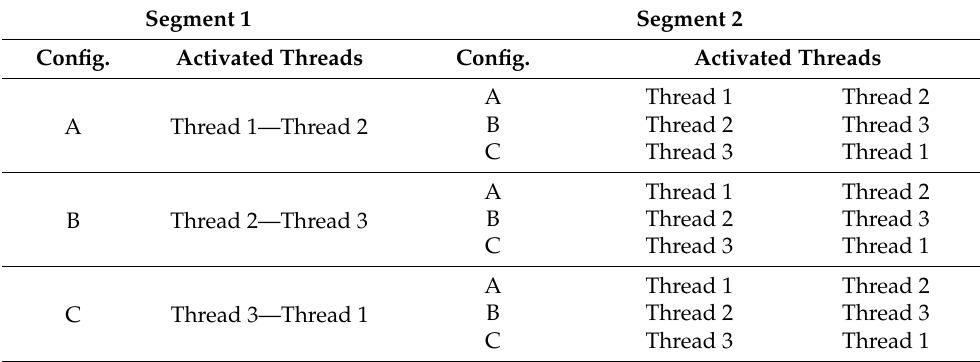
Table 2. All possible activation combinations. Source: authors.